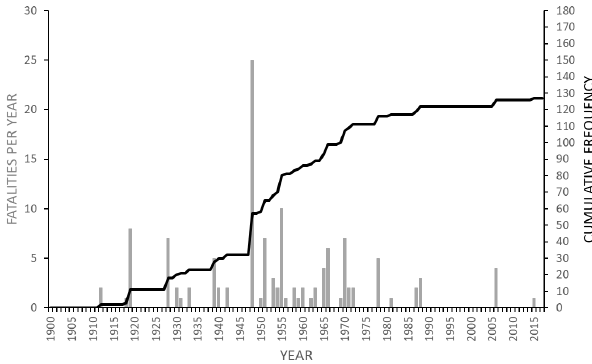
Figure 9. Statistics of fatalities caused by landslides in the analyzed time